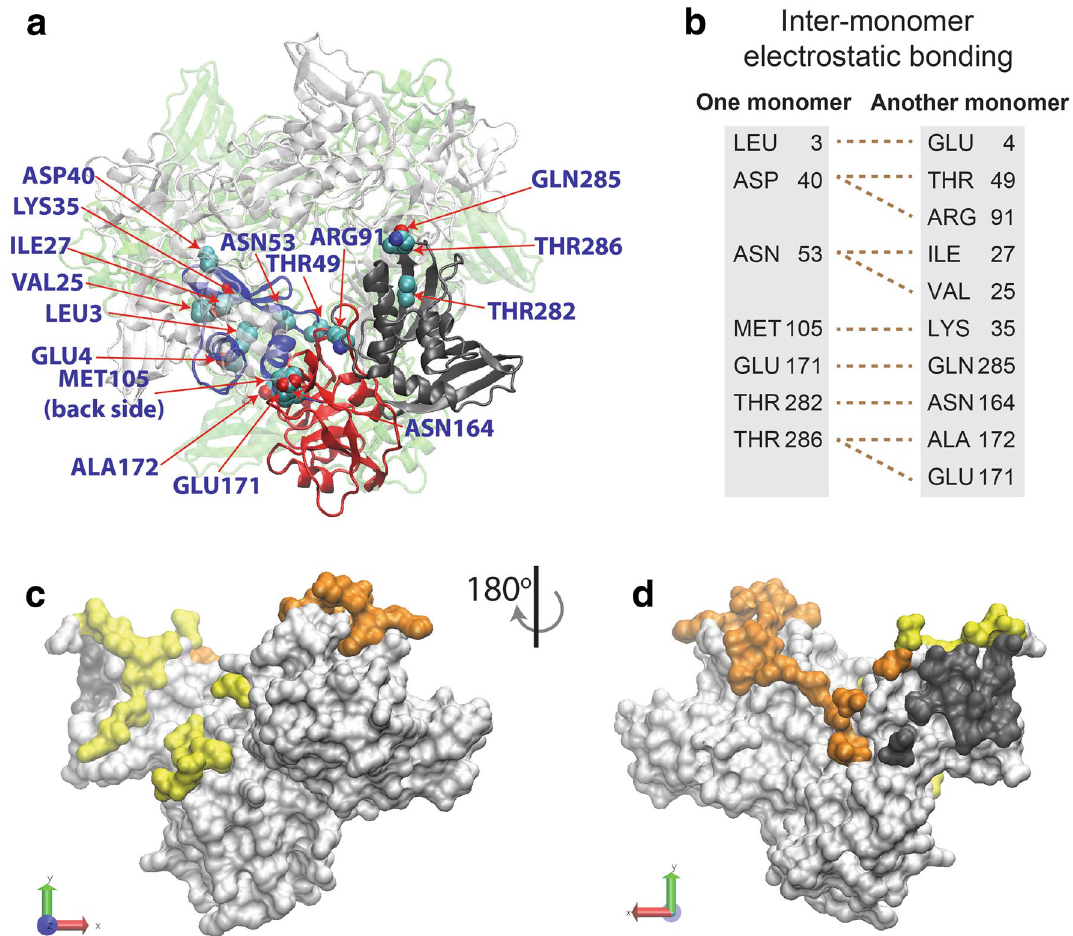
Figure 1. Structural features of the Nsp15 monomer in the apo hexamer. ( a ) A representative monomer structure (N-term domain: blue, Mid domain: red, and C-term domain: grey), the other dimers (transparent white) in the front trimer, and the backside trimers (pale green) are depicted. The residues shown by CPK models are involved in electrostatic bonding (salt bridges and hydrogen bonds) between the pairs of amino acids listed in ( b ). In ( b ), broken lines indicate the pattern of the electrostatic bondings. ( c, d ) The residues that form inter-monomer interfaces. The white area denotes non-interfacial residues, while other colors (yellow, orange, and dark grey) indicate the hexamer interface residues. In ( d ), the protein is rotated 180° around the y axis. The structure images in this paper were created using VMD 60 unless otherwise